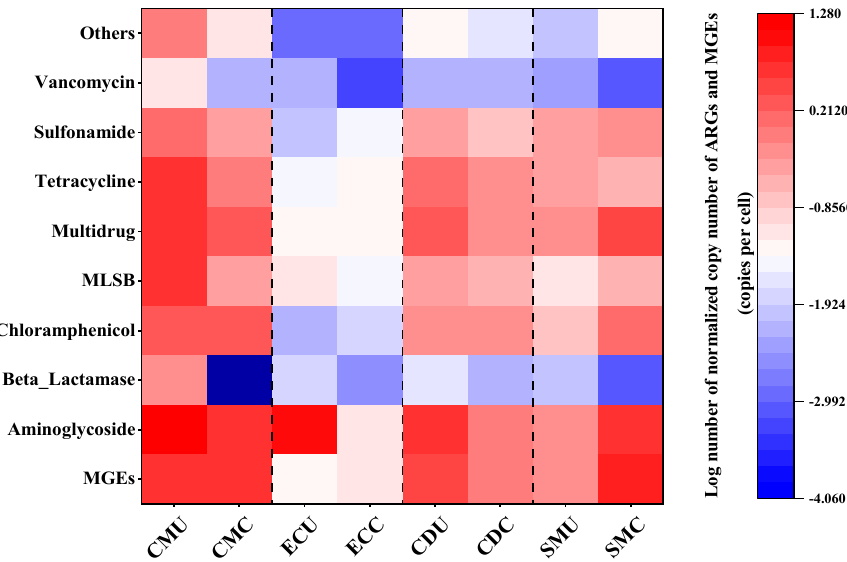
Figure 7. Resistance gene profile from eight organic fertilizer samples. Each column is labeled with a sample name, and each row is the result from a single primer set. Resistance profiles that confer resistance to all major classes of antibiotics included resistance to aminoglycoside, beta-lactamase, chloramphenicol, MLSB, multidrug, tetracycline, vancomycin, and sulfonamide.